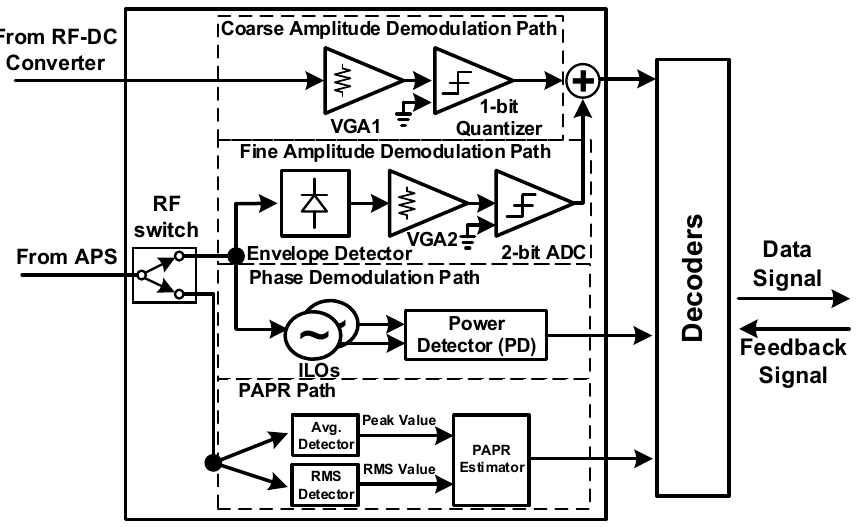
Figure 6. Block diagram of the proposed information decoding (ID) path.